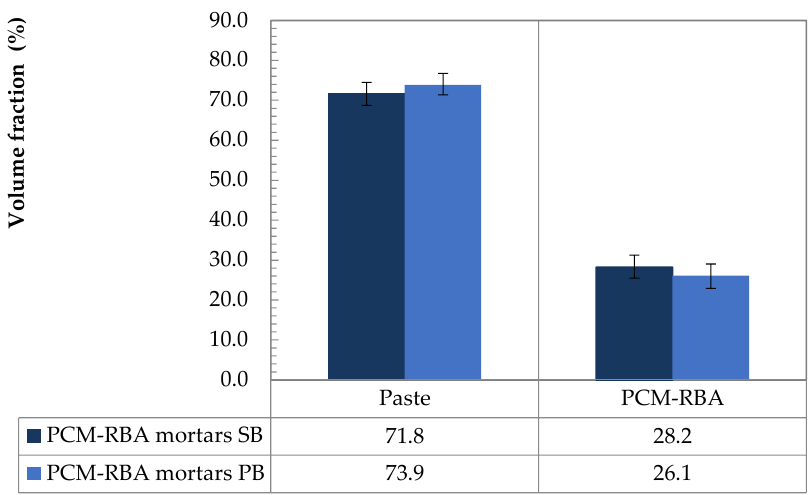
Figure 6. Volume fractions of paste and PCM ‐ RBA determined by image ‐ analysis.